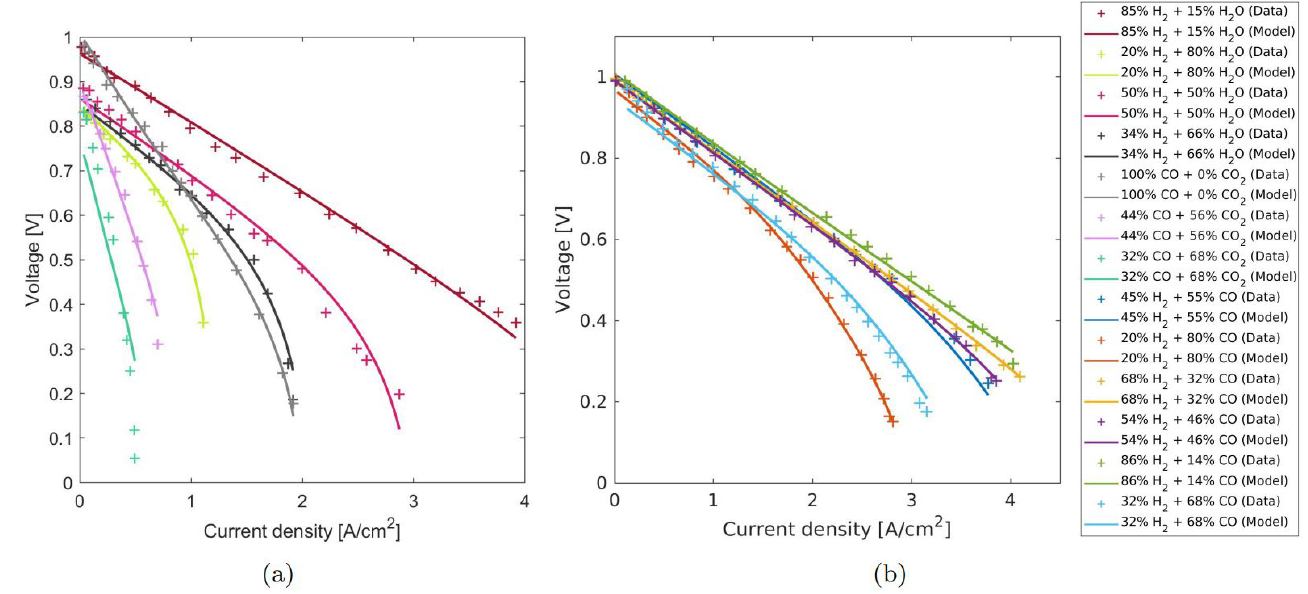
Figure 6. The second test in the scope of the extrapolation validation; the results of the calibrated model on ( a ) the training data set consisting of the last seven polarisation curves and ( b ) the validation data set consisting of the first six polarisation